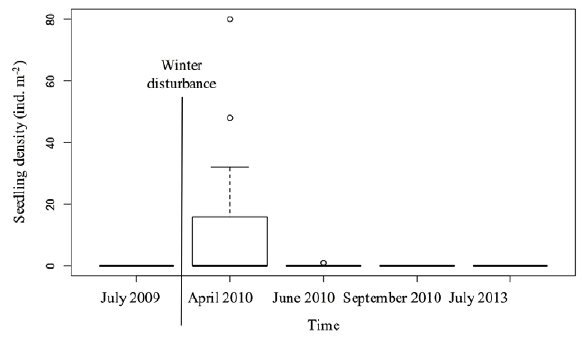
Fig. 2. – Seedling density (ind m –2 ) in a Zostera marina meadow at Ponta do Adoxe sampled before disturbance, and after disturbance in four periods from April, 2010 to July